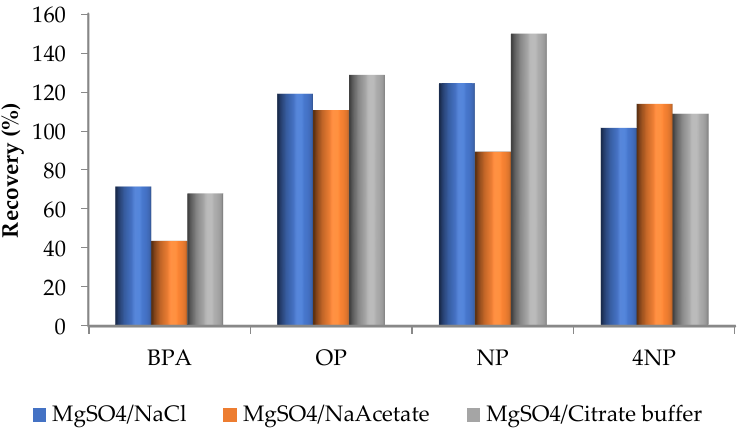
Figure 1. The effect of the extraction salts from a milk sample fortified at 100 ng g − 1 on the analytes’ recovery.